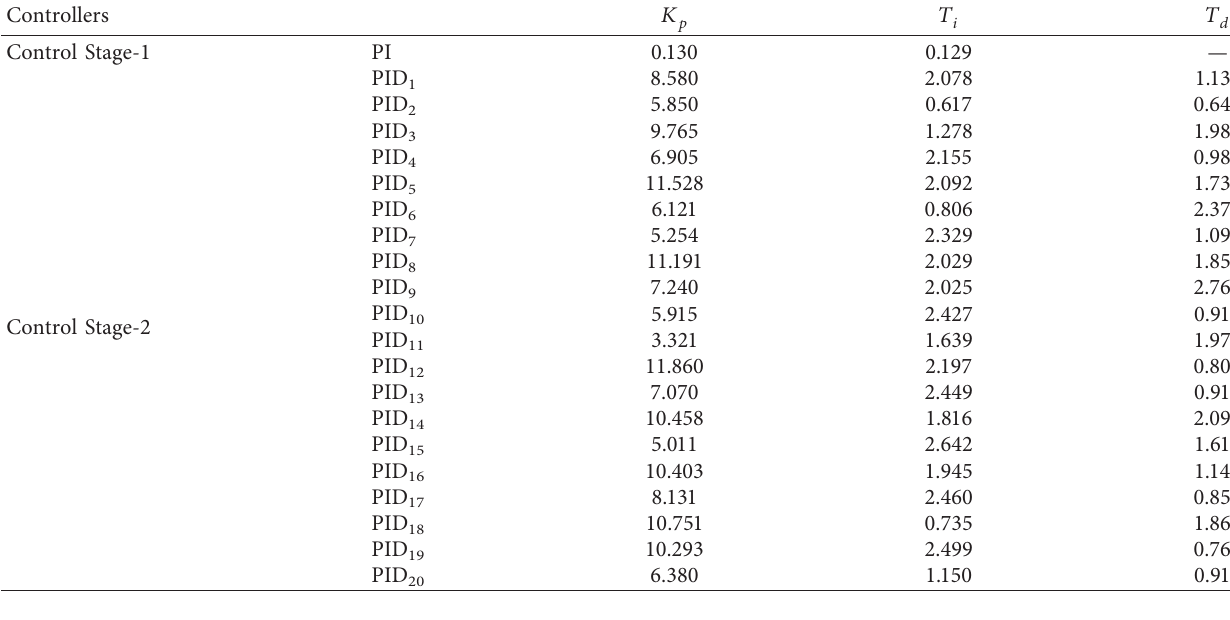
Table 4: Central airflow control unit